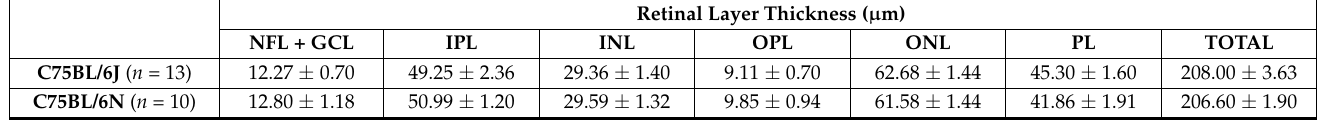
Figure 3. Retinal layer thickness and RGC function in C57BL/6J versus –N mice: ( a ) overview of different retinal layers acquired via optical coherence tomography (OCT); scale bar = 50 µ m; ( b ) mild thinning of the photoreceptor layer is apparent in C57BL/6N ( n = 10) versus C57BL/6J ( n = 13) mice. Two-way ANOVA with Šídák’s post hoc test, ** p ≤ 0.01; ( c ) no difference in pSTR amplitude or latency was detected, revealing identical functioning of RGCs in C57BL/6J ( n = 13) versus C57BL/6N ( n = 10) mice; unpaired, two-tailed t-test, ns = non-significant. Key: NFL = nerve fiber layer; GCL = ganglion cell layer; IPL = inner plexiform layer; INL = inner nuclear layer; OPL = outer plexiform layer; ONL = outer nuclear layer; PL = photoreceptor layer; TOTAL = total neuroretina. Table 2. Overview of average retinal layer thickness in C57BL/6J and -N mice, measured via OCT imaging. Data are shown as mean ± SD. Key: NFL = nerve fiber layer; GCL = ganglion cell layer; IPL = inner plexiform layer; INL = inner nuclear layer; OPL = outer plexiform layer; ONL = outer nuclear layer; PL = photoreceptor layer; TOTAL = total neuroretina.